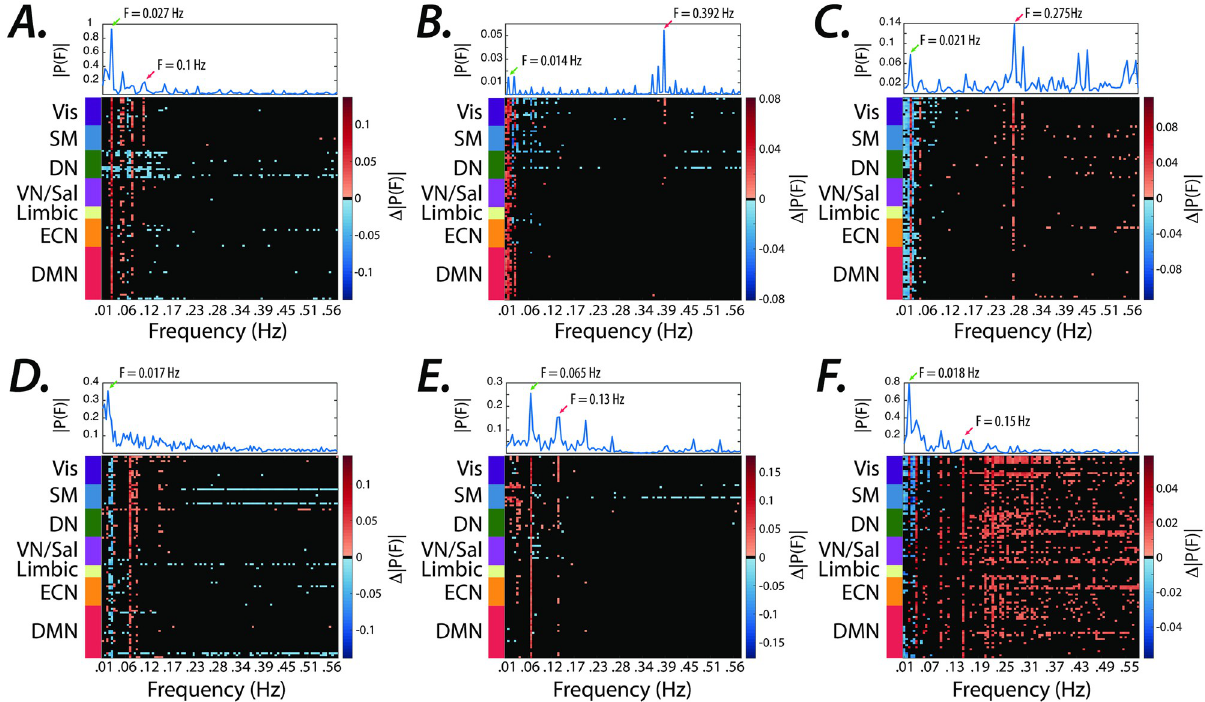
Fig 4. Matching the spectral profile of the known and estimated external inputs. (A–F) The difference between the average Fourier transform of the estimated inputs to all brain regions during tasks compared to that of other task conditions (see Materials and Methods for details). Top panels display the average (two sessions) spectral profile of the known boxcar regressors for each task (see S5 Fig in S1 File). Note the significant changes in the spectrum at expected task-specific frequency peaks across several brain regions, at low ( < 0.1 Hz) and high ( > 0.1 Hz) frequencies represented with red and green arrows, respectively. Frequencies for which brain regions did not pass the significance level (Wilcoxon rank-sum test, FDR p < 0.0005) are represented in black.